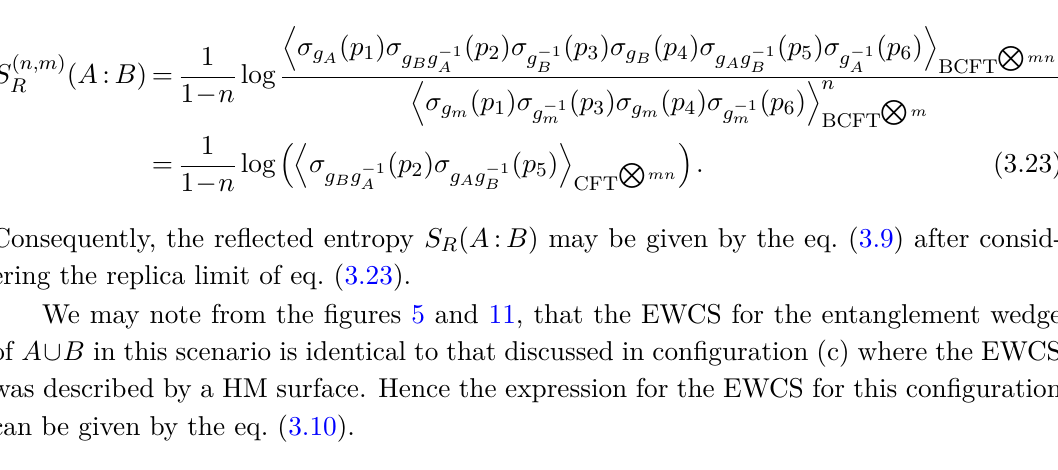
Figure 11 . The points in the two copies of BCFT 2 s in a TFD state are identified as q b and q b = r I − (cid:15) which are the mirror images of the points p 1 = r I + (cid:15) and p 6 = r I + (cid:15) respectively with 6 respect to the b -boundary. The other points are identified similarly as in figure